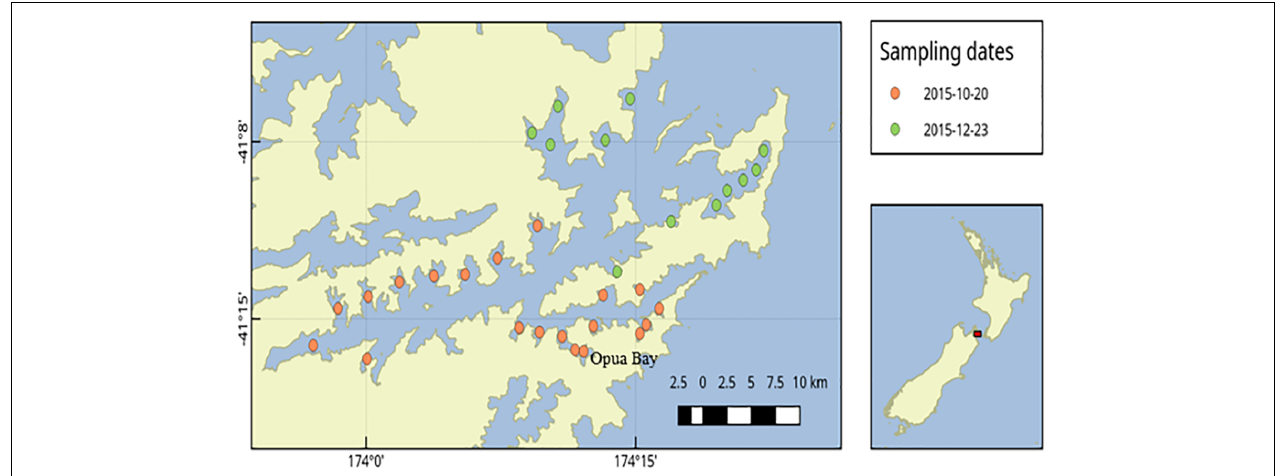
FIGURE 1 | Sediment sampling stations in Queen Charlotte Sound, Marlborough Sounds, New Zealand.